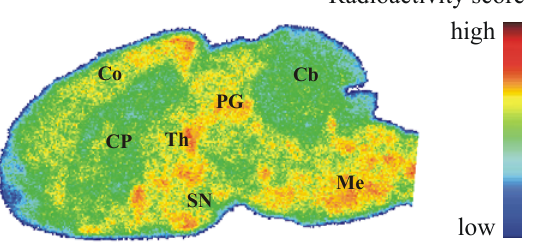
Figure 5. Representative color-coded autoradiographic image of a sagittal mouse brain slice. Distribution of [ 18 F] IV in mice brain ex vivo , obtained at 30 min p.i. of 100